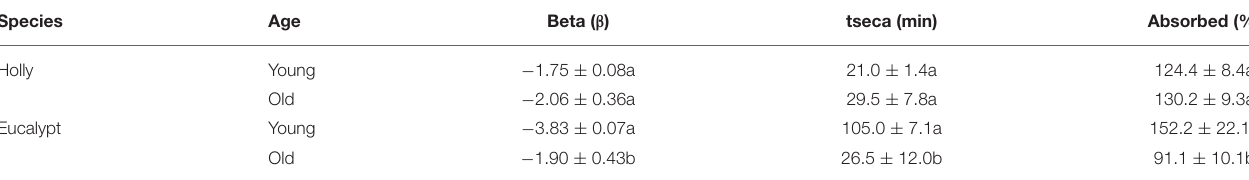
TABLE 3 | Transpiration parameters of natural adaxial cuticles isolated from holly and blue gum eucalypt leaves. Species Age Beta ( β ) tseca (min) Absorbed (%)